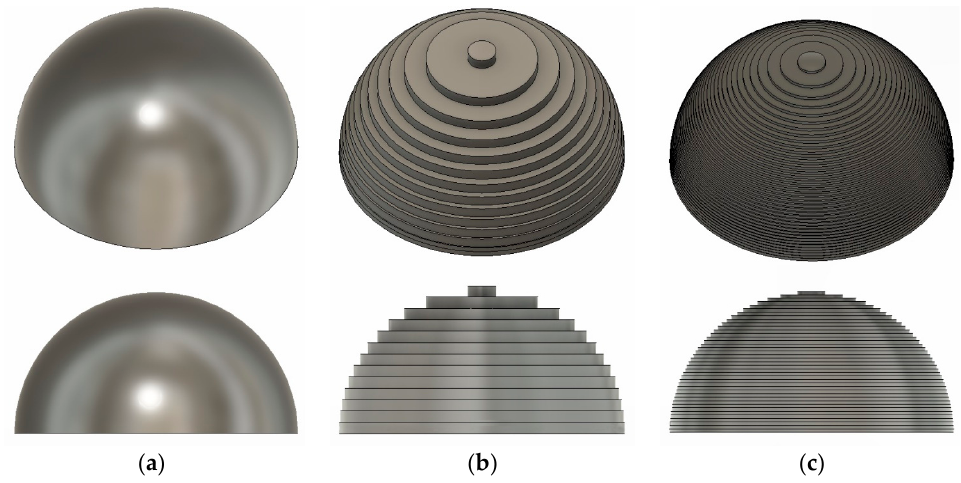
Figure 1. The influence of layer height on additive manufacturing (AM) surface finish ( a ) Ideal sphere ( b ) Sphere sliced at 0.8 mm layer height, typical of commercial paste extruders ( c ) Sphere sliced at 0.25 mm layer height.